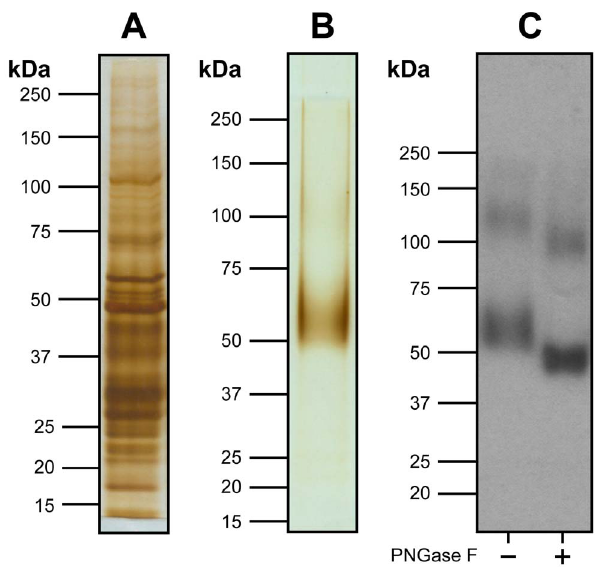
Figure 2. Purification and biochemical characterization of recombinant hSVCT1. Silver-stained SDS/polyacrylamide gels of detergent-solubilized membranes prior binding to cobalt resin (A) and purified hSVCT1 after metal affinity chromatography (B). A prominent hSVCT1 band is discerned between the 50 and 75 kDa markers. (C) Western blot analysis of PNGase F untreated ( 2 ) and treated ( + ) purified hSVCT1. A clear shift towards lower molecular mass and a more compact appearance of the hSVCT1 monomer and dimer bands is observed after PNGase F treatment of purified protein. This indicates N -linked glycosylation of hSVCT1 when expressed in Xenopus laevis oocytes. In (A)-(C) samples were run on 6% SDS/polyacrylamide gels, and in the Western blot displayed in (C) an anti-HA antibody was used.